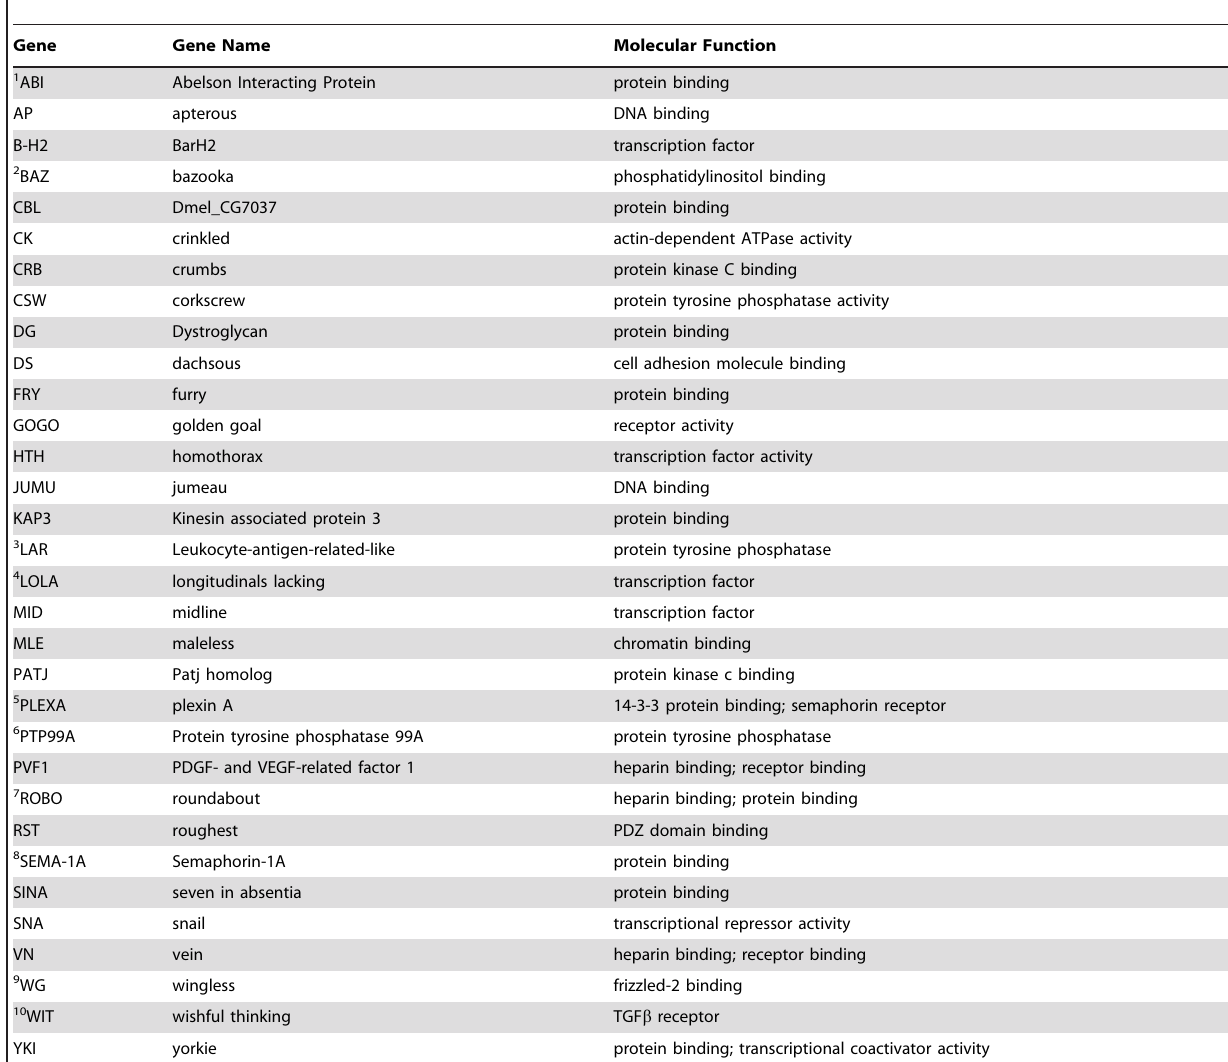
Table 1. Putative mRNA targets for co-regulation by miRs-8 and -289 that also map to a neuron-related functional annotation cluster (GO term